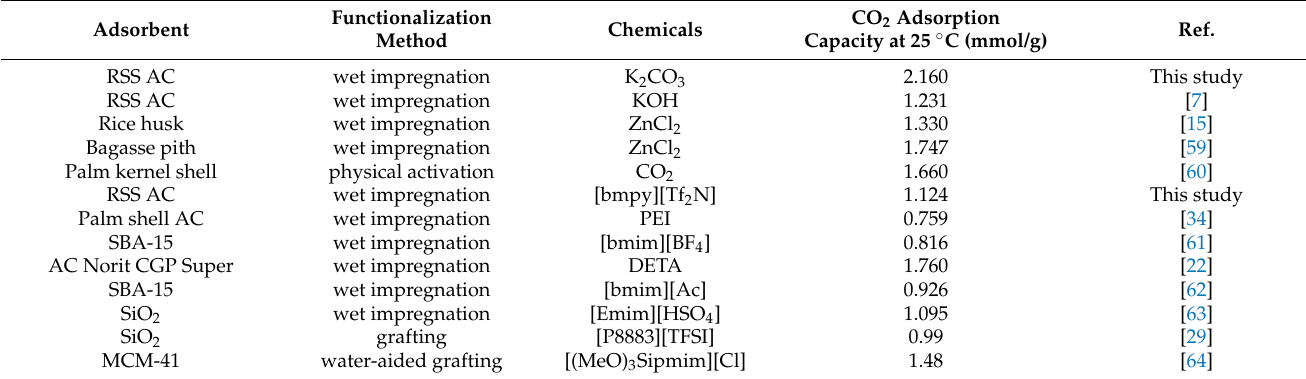
Table 4. A comparison of CO 2 adsorption performance of various